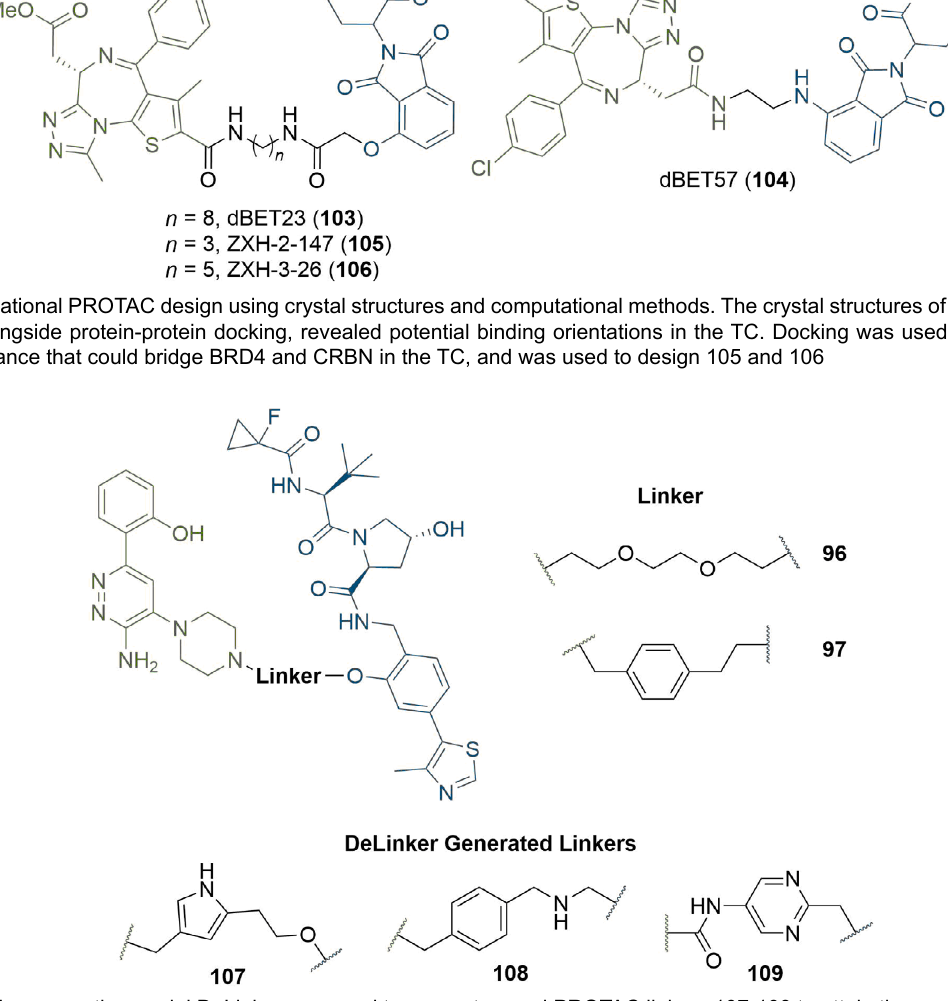
Explor Target Antitumor Ther. 2020;1:273-312 | https://doi.org/10.37349/etat.2020.00018